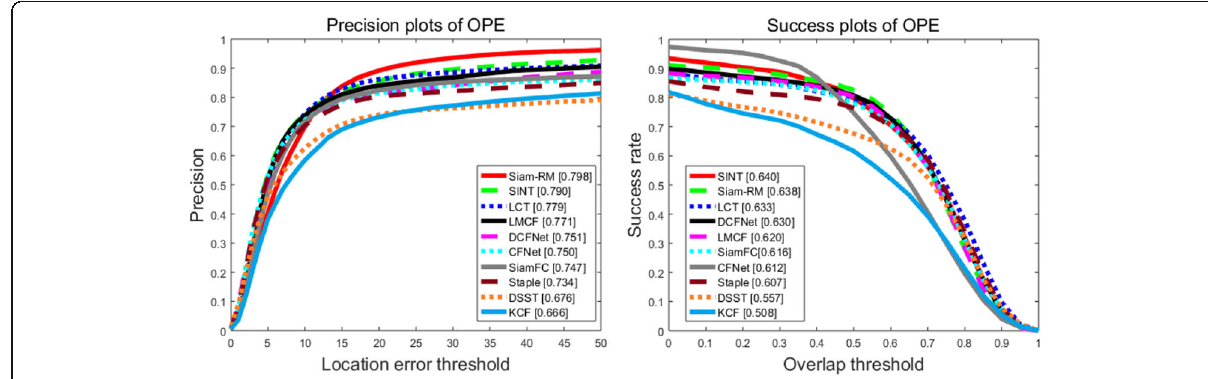
Fig. 6 The precision plots and the success plots of OPE for top 10 trackers. Each tracker is ranked by the score of tracking performance. For precision plots, the results at the error threshold of 20 are used for ranking. For success plots, the area under the curve (AUC) is used to rank the